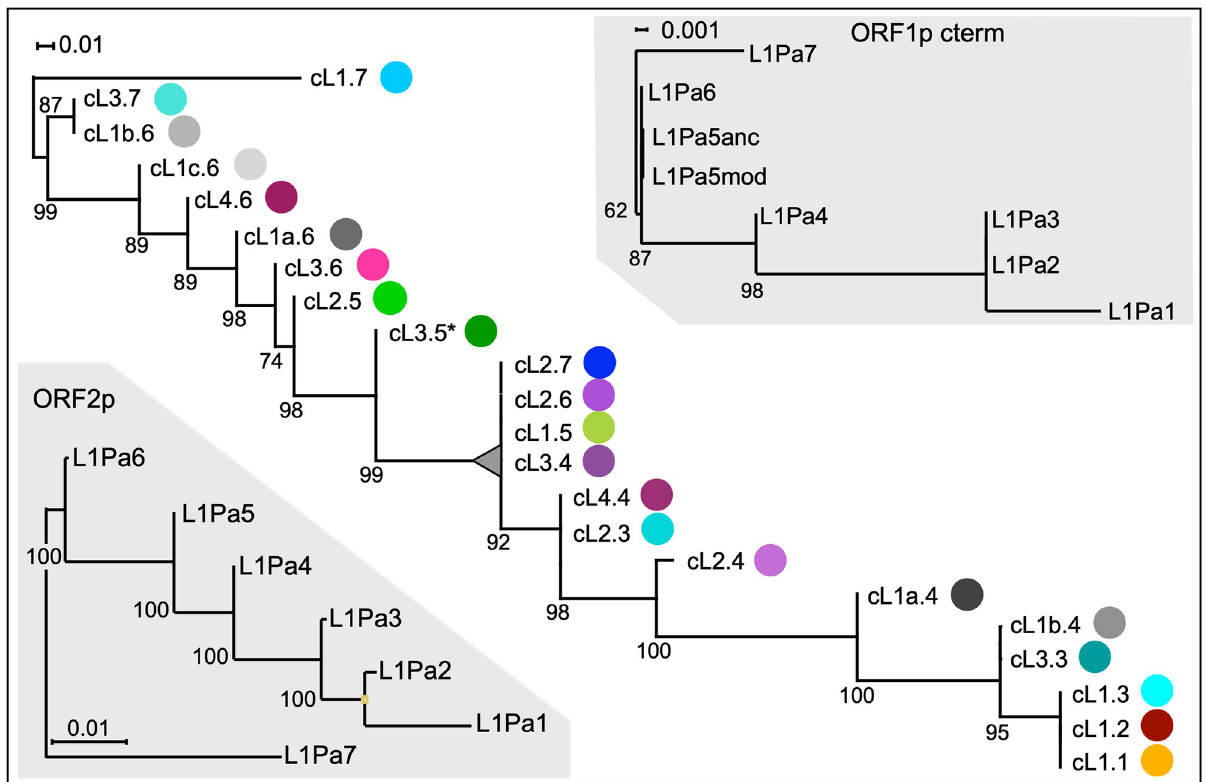
Fig 4. Coiled coil phylogeny. Maximum likelihood trees of the coiled coil clusters and C-termini were built on their 50% consensus sequences with the amino acids encoded by CG-affected codons treated as missing data. Note the 10-fold lower scale of the branch lengths for the C-terminus tree. The colored circles at the tips of the coiled coil cluster tree correspond to the cluster colors in Fig 3, panel A-F. The numbers at each node give its frequency as % of 1000 bootstrap replicates. The ORF2 tree was generated from amino acid consensus sequences of the human version of our previously described collection of L1Pa2 –L1Pa7 human/chimpanzee orthologues [51] and the currently active human L1Pa1 family (in particular, Ta1-d 5), represented here by the L1.3 element [52]. This tree is consistent with a previously described tree built from the 3’ 2 kb of nucleic acid sequence which includes the 3’UTR but mostly ORF2 sequence (Figure 4A in